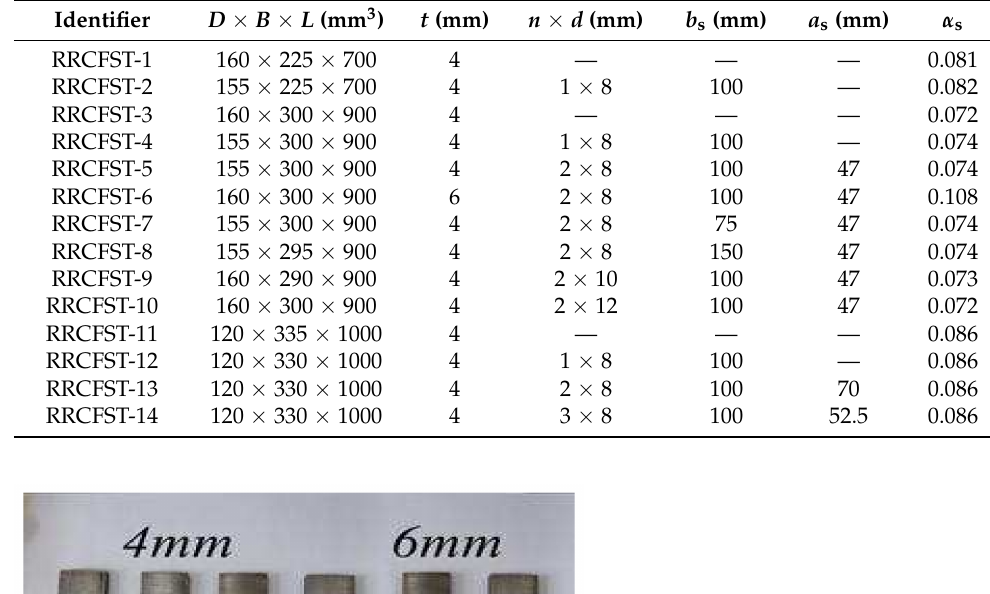
Table 1. Main parameter of the RRCFST columns.